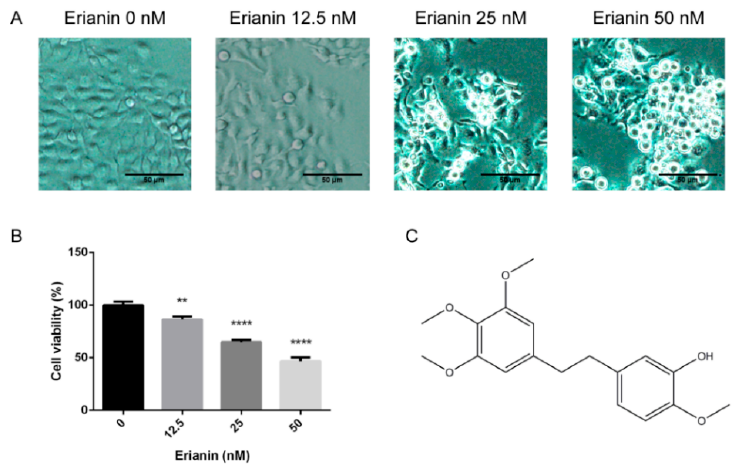
Figure 1. Effects of erianin on the morphology and viability of a human keratinocyte cell line (HaCaT). Cells were treated with various concentrations of erianin (12.5 nM, 25 nM and 50 nM) for 24 h. ( A ) Microscopy images of cellular morphology. Scale bar = 50 µ m. ( B ) Cell viability was detected by the MTT assay. ( C ) The chemical structure of erianin. The values are expressed as means ± standard deviation (SD) ( n = 3). ** p < 0.01, **** p < 0.001, significantly different compared with the untreated